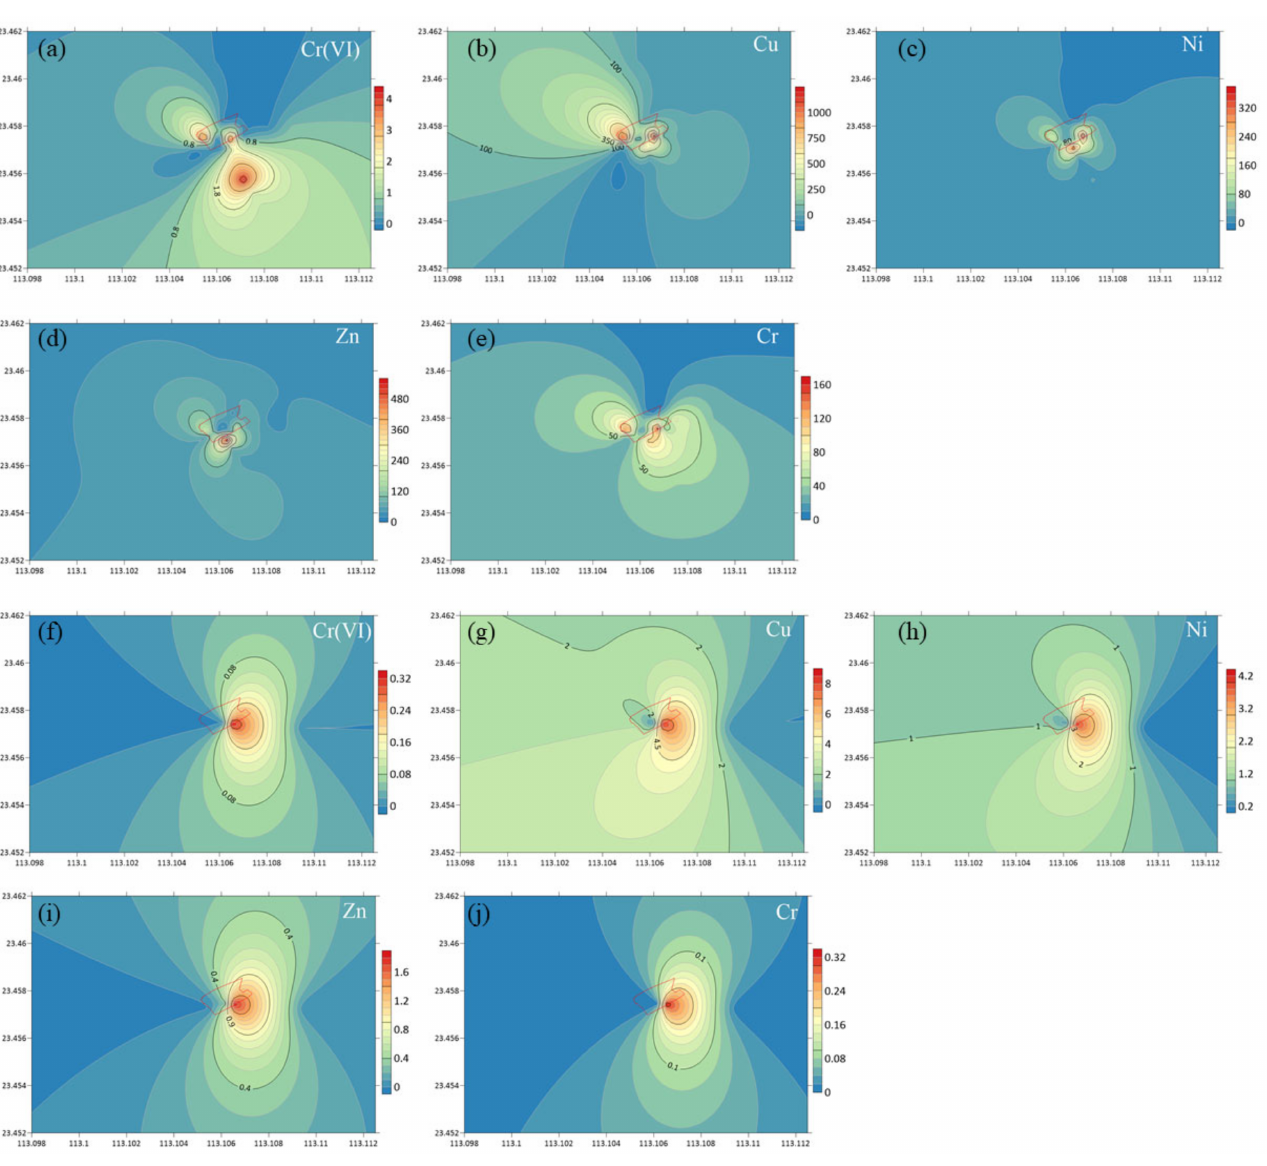
Figure 3. Distribution of heavy metals in surface soil (0–20 cm) of Factory B and its surrounding area. ( a – e ) are the contour plots of the heavy metal concentration (mg/kg) in soil. ( f – j ) are the contour plots of the heavy metal concentration (mg/L) in